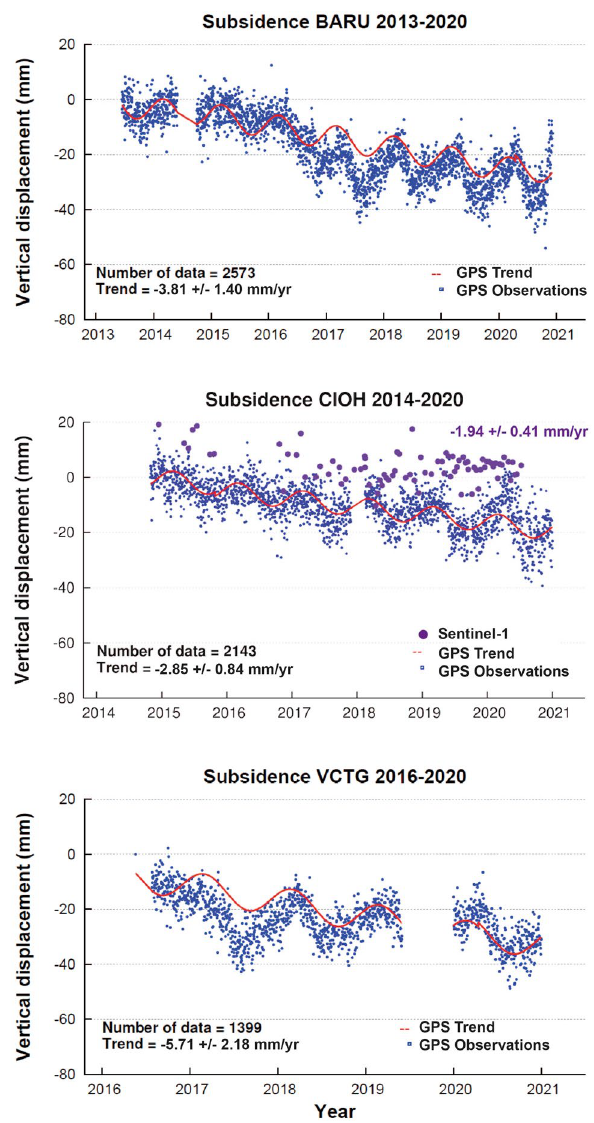
Figure 3. Time series (2013–2020) of subsidence (mm) at three GPS geodetic stations (Fig. 1c) in Cartagena (Data from the GeoRED Project, Space Geodesy Research Group of the Colombian Geological Survey-CGS, Servicio Geológico Colombiano). Sentinel-1 vertical displacement observations (mm) during the 2014–2020 period are plotted (purple) at the GPS-tide gauge station (CIOH) (center). GPS time series generated by GNUPLOT v 4.2 (http:// www. gnupl ot.